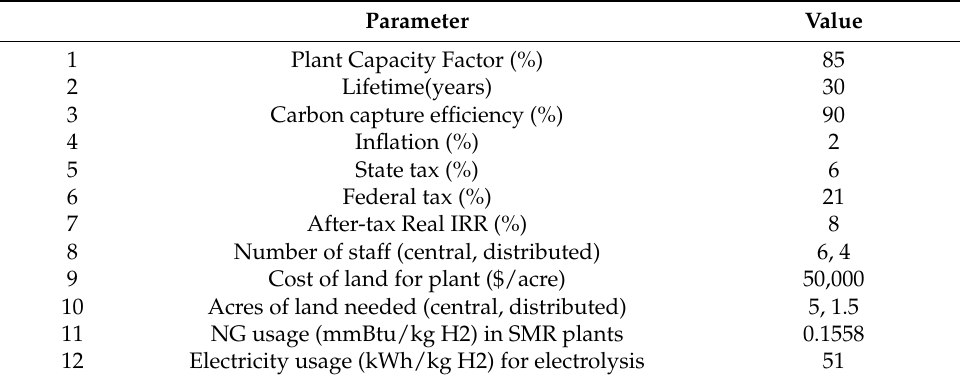
Table A1. Base assumptions in H2A [38,54,55].